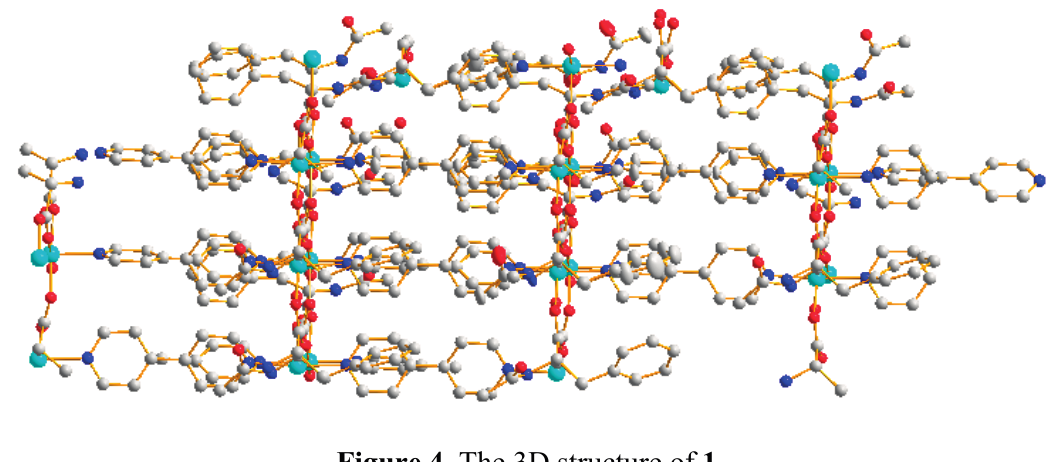
Figure 3. The 1D chained structure of 1 .